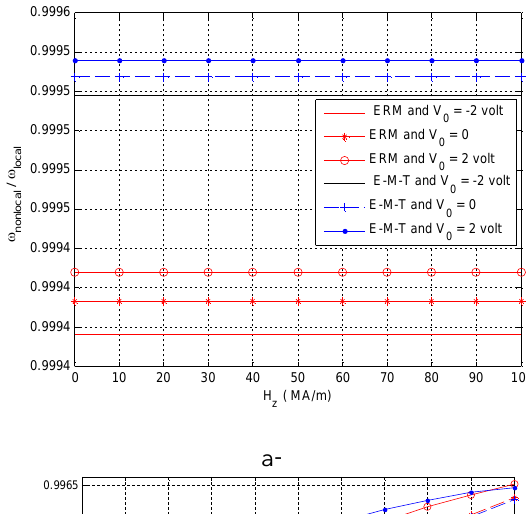
  of piezoelectric Fig. 2. / nonlocal local nanocomposite plate versus the shear constant